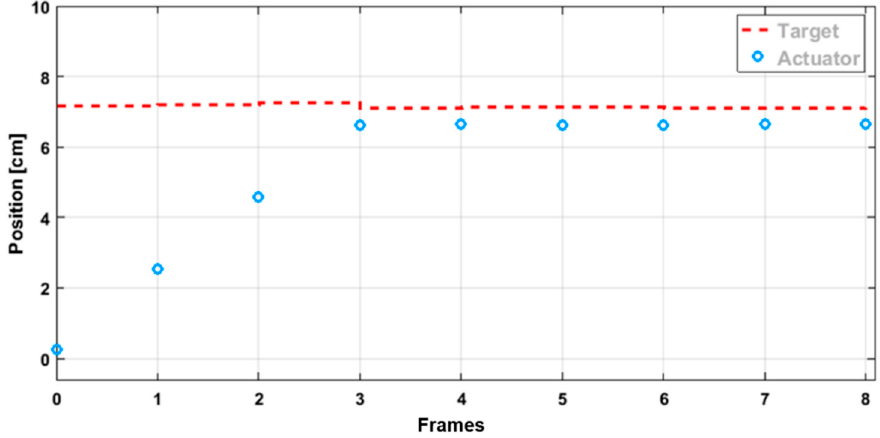
Figure 9. Actuator tracking the target object placed in a fixed position.